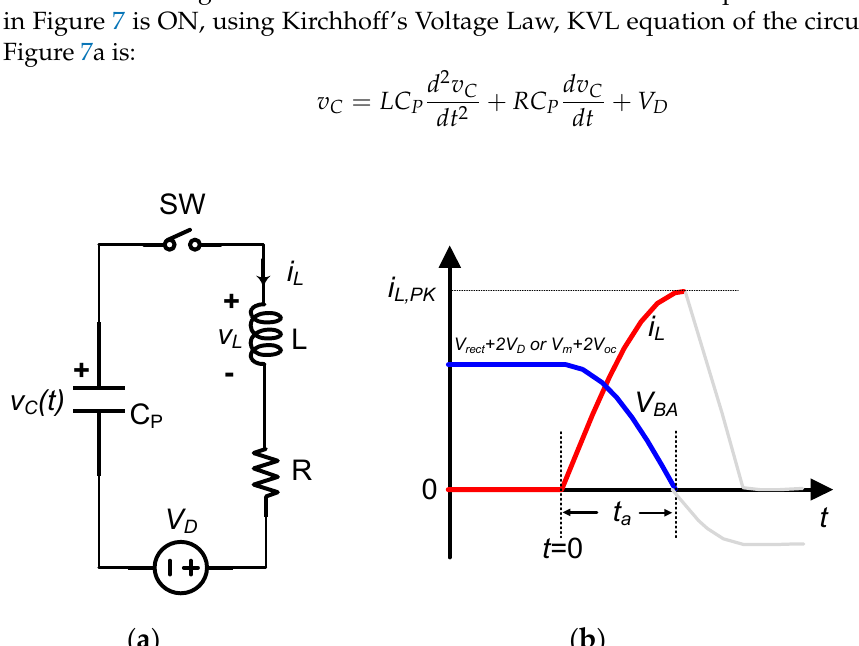
Figure 7. ( a ) Circuit model of the first resonant loop, and ( b ) its